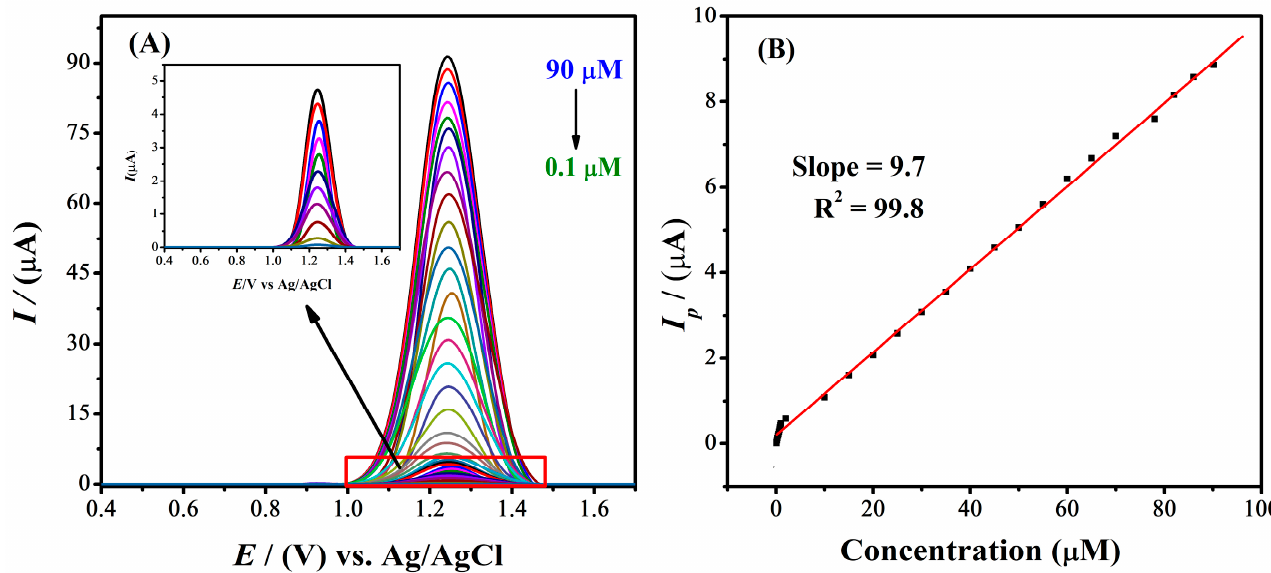
Figure 6. ( A ) Differential pulse voltammograms for different concentrations of IBP using an MWCNTs/Ag-ZnO/GCE under pre-optimized conditions at a scan rate of 10 mVs − 1 , ( B ) calibration plot obtained by DPV data for various concentrations of IBP.